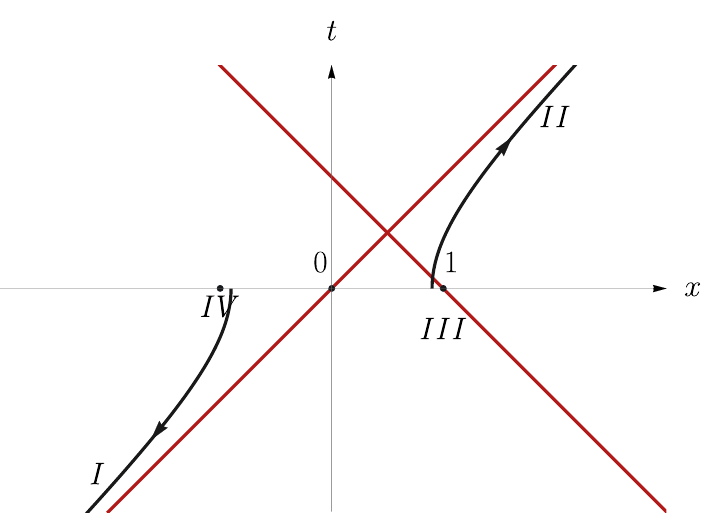
Figure 16 . The image of the trajectory of subsection 2.4 — with a small fixed value of θ — onto the ρ